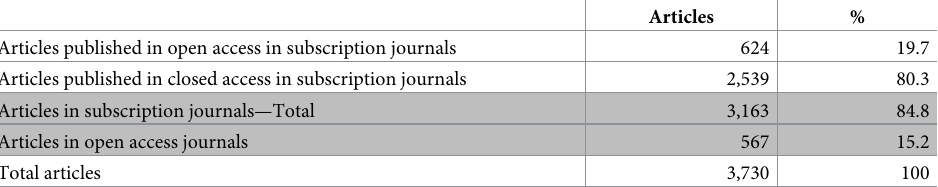
Table 8. Articles published in subscription journals versus open access journals.